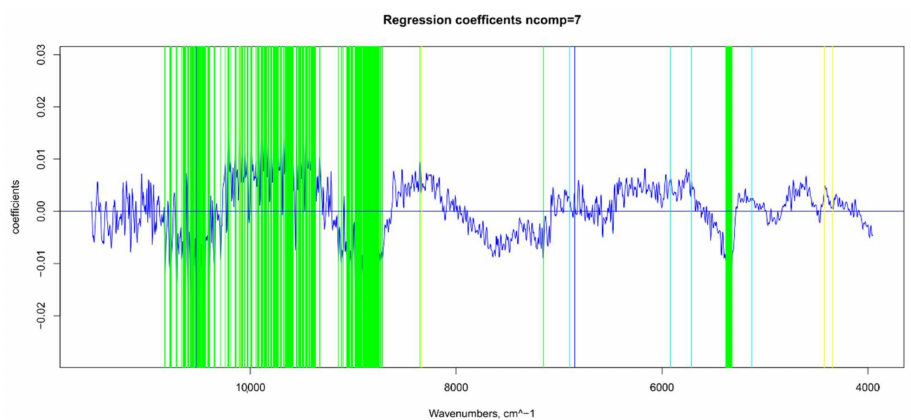
Figure 5. Beta-coefficient values after outlier removal and mean center: values selected for ANN (in green), main NIR peaks for water (in blue), sugar and water (in light blue), and sugar and organic acids (in